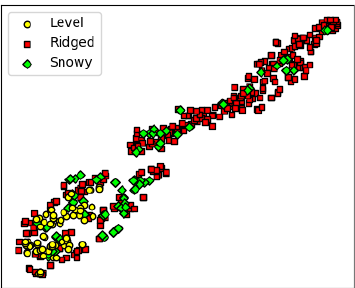
Figure 14. The t -distributed stochastic neighbor embedding dia- gram for the encoded input, using the first fully connected layer (feature vector of size 64) (van der Maaten and Hinton, 2008). The level and ridged categories are most clearly clustered, although the snowy category may also be a cluster. There is some overlap be- tween the snowy and ridged clusters, which may reflect how ridges are often alongside snow features. It is also possible that the ridged category contains multiple different clusters. This result suggests that the manually determined surface categories shown in Figs. 7 and 12 are pertinent, but perhaps not the most relevant, for estimat- ing SIT given different surface